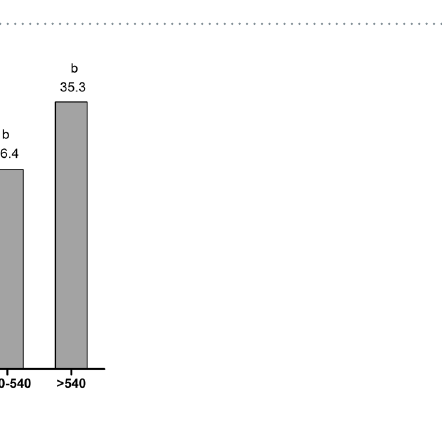
Figure 1. Simple renal cysts (SRC) prevalence in groups with different serum uric acid levels. The subjects were divided into seven groups by 60- µ mol/L increments in serum uric acid (no further stratification for subjects with serum uric acid level ≤ 240 µ mol/L or > 540 µ mol/L). The P-value was < 0.05 when the a and b groups were